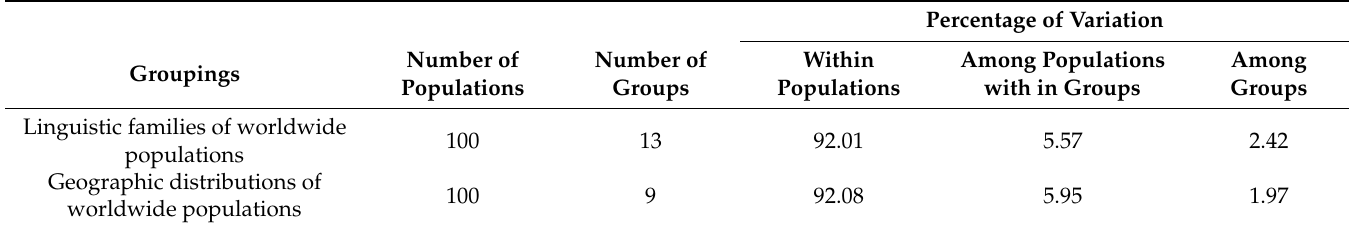
Table 2. Analysis of molecular variance (AMOVA) results based on di ff erent groups for worldwide populations.